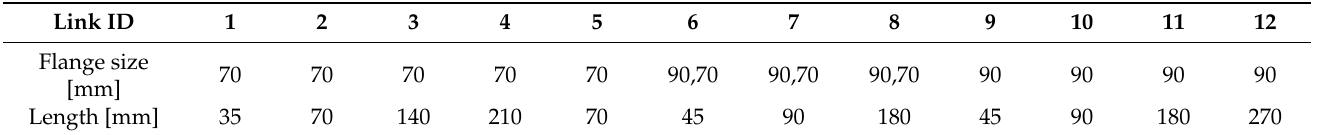
Table 4. Parameters of the basic